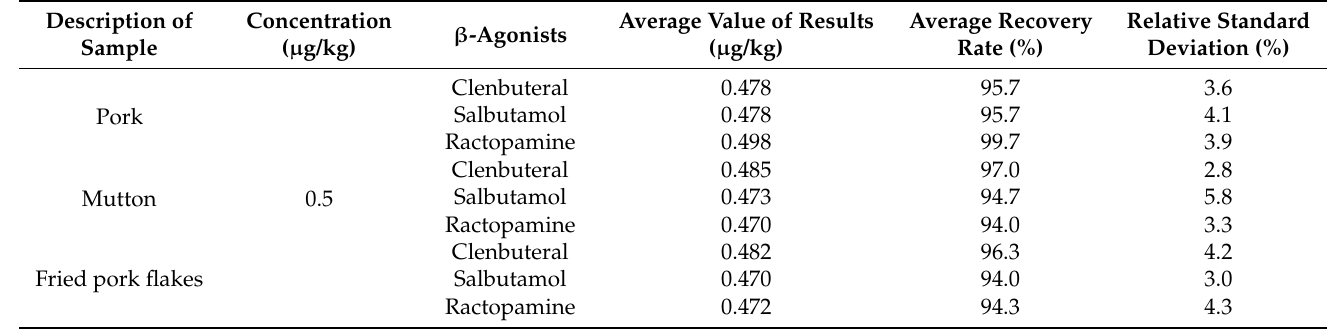
Table 3. Precision and recovery rate of standard addition samples of three β -agonists at the standard addition concentration of 0.5 µ